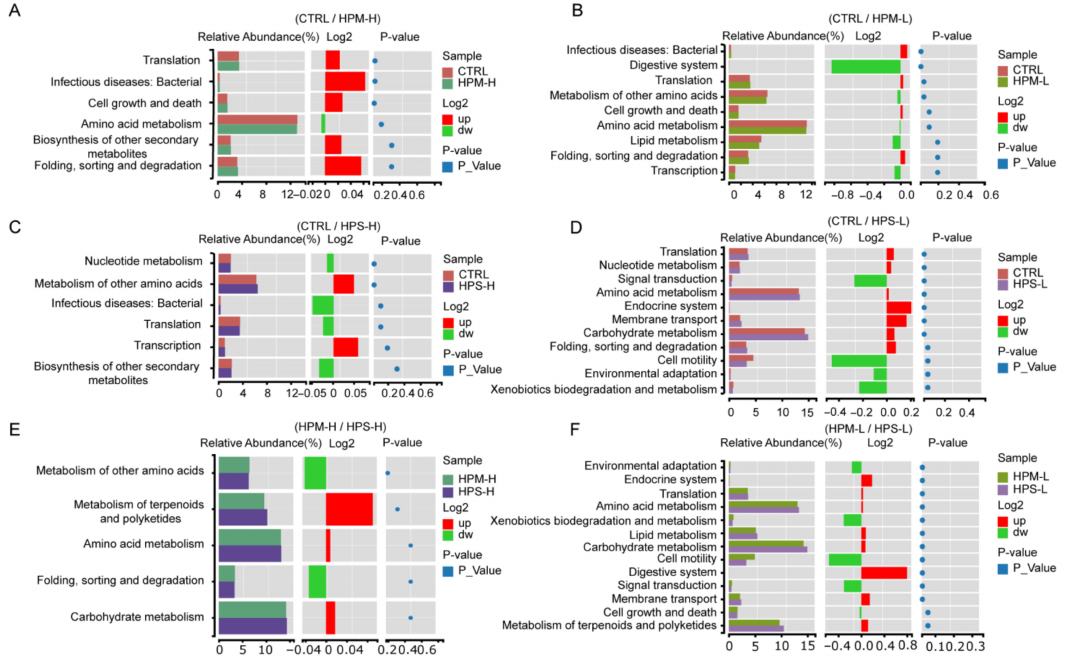
Figure 4. Function prediction of gut microbiota. On the left is the relative abundance histogram of each group; in the middle is the log2 value of the mean relative abundance ratio of the same pathway in the two groups; on the right is the p -value obtained by the Wilcox test. ( A ) CTRL Vs HPM-H; ( B ) CTRL Vs HPM-L; ( C ) CTRL Vs HPS-H; ( D ) CTRL Vs HPS-L; ( E ) HPM-H Vs HPS-H; ( F ) HPM-L Vs